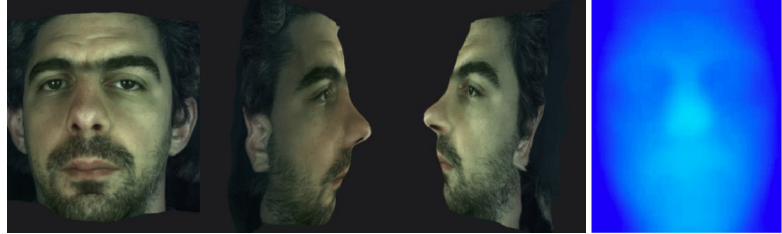
Figure 13. Depth map and textured reconstruction using Raytrix software.